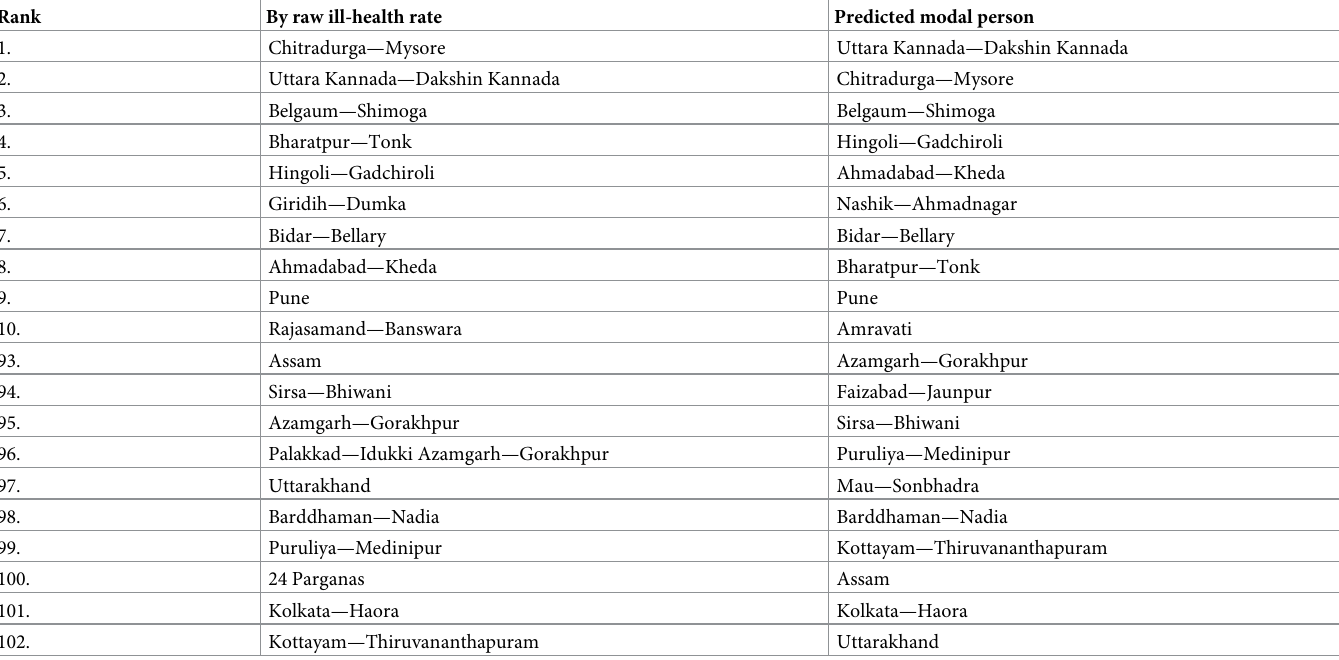
Table 3. The HRs with the highest and lowest ill health